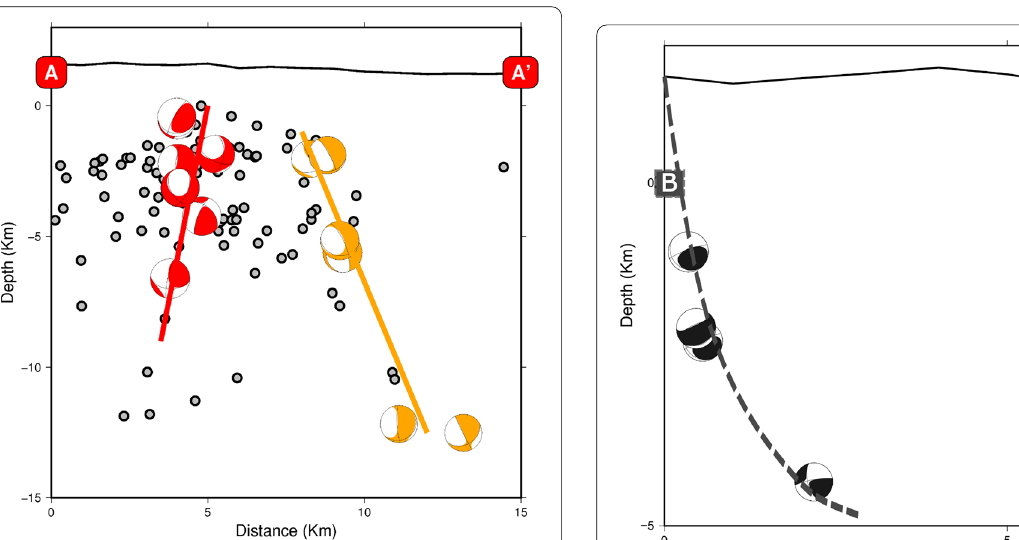
Fig. 6 The vertical distribution of the southeast group along the AA’ line in Fig. 5. The thick lines are estimated fault planes Fig. 7 The vertical distribution of the normal-faulting group along the BB’ line in Fig. 5. The dashed line is an estimated fault plane